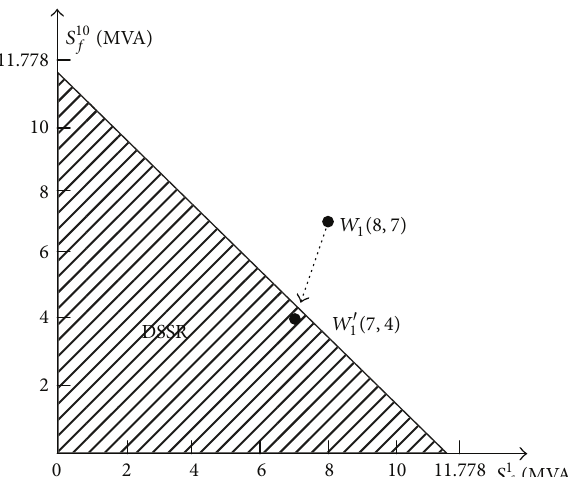
Figure 9: 2D DSSR cross-section and preventive control.